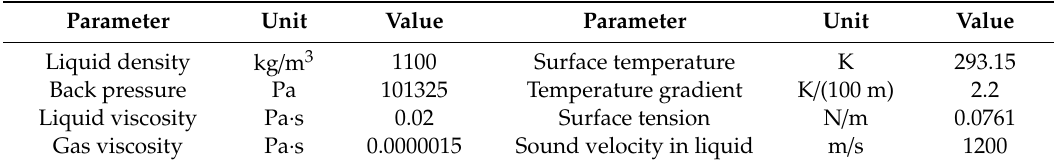
Table 2. Calculation